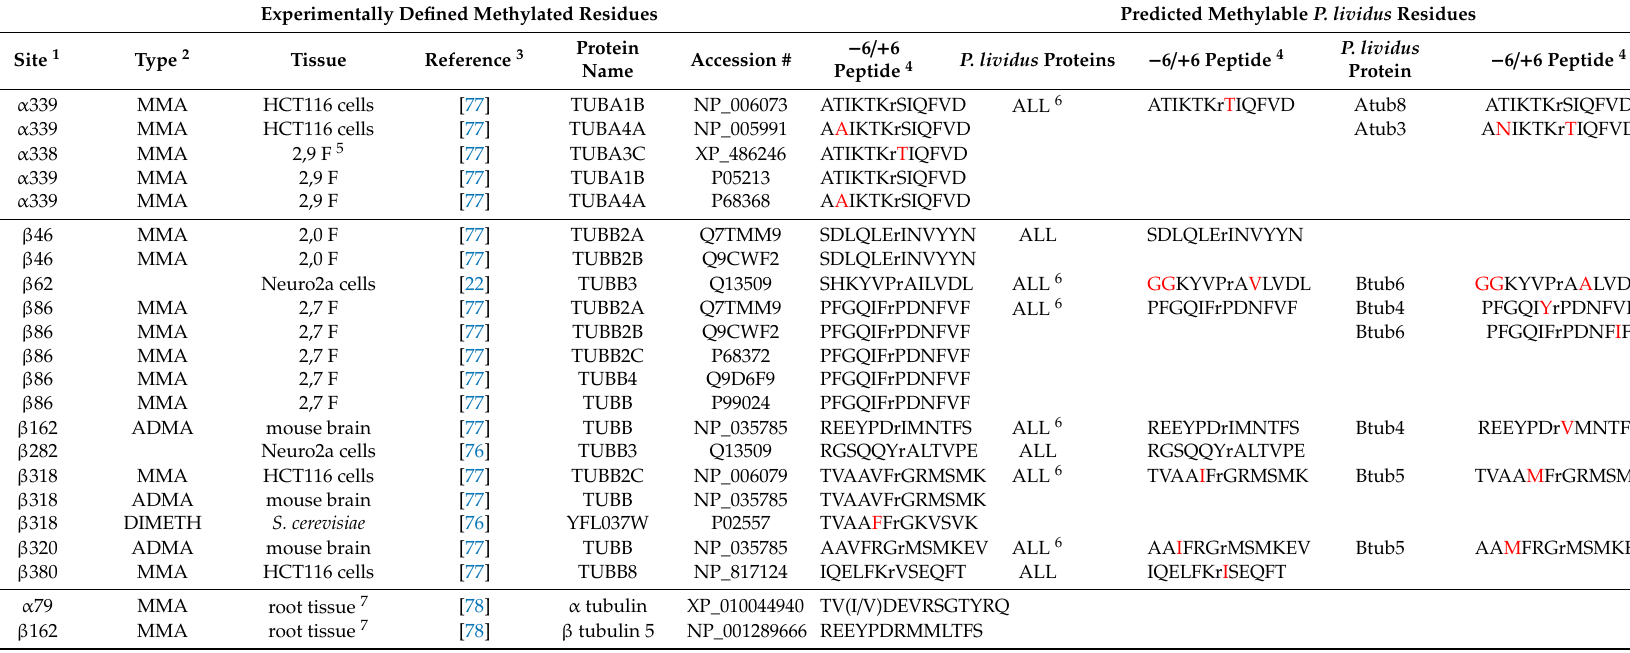
Table 5. Arginine methylation sites identified in tubulins of other organisms, their sequence environment ( − 6 /+ 6 peptide) and corresponding sequences in P. lividus